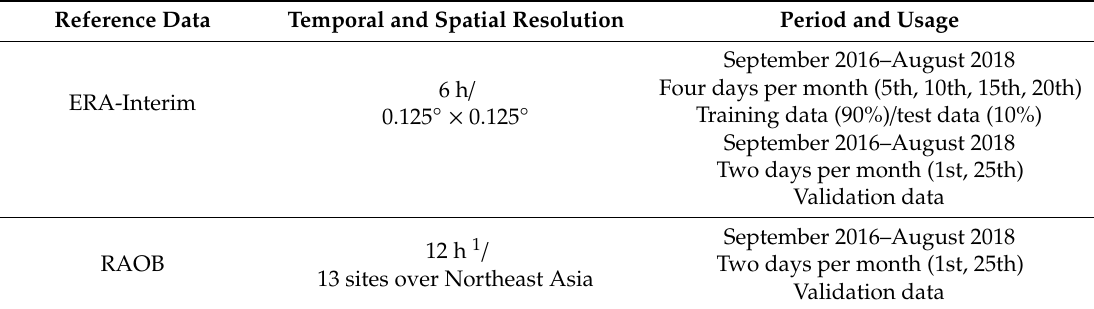
Table 2. Description of the reference data and